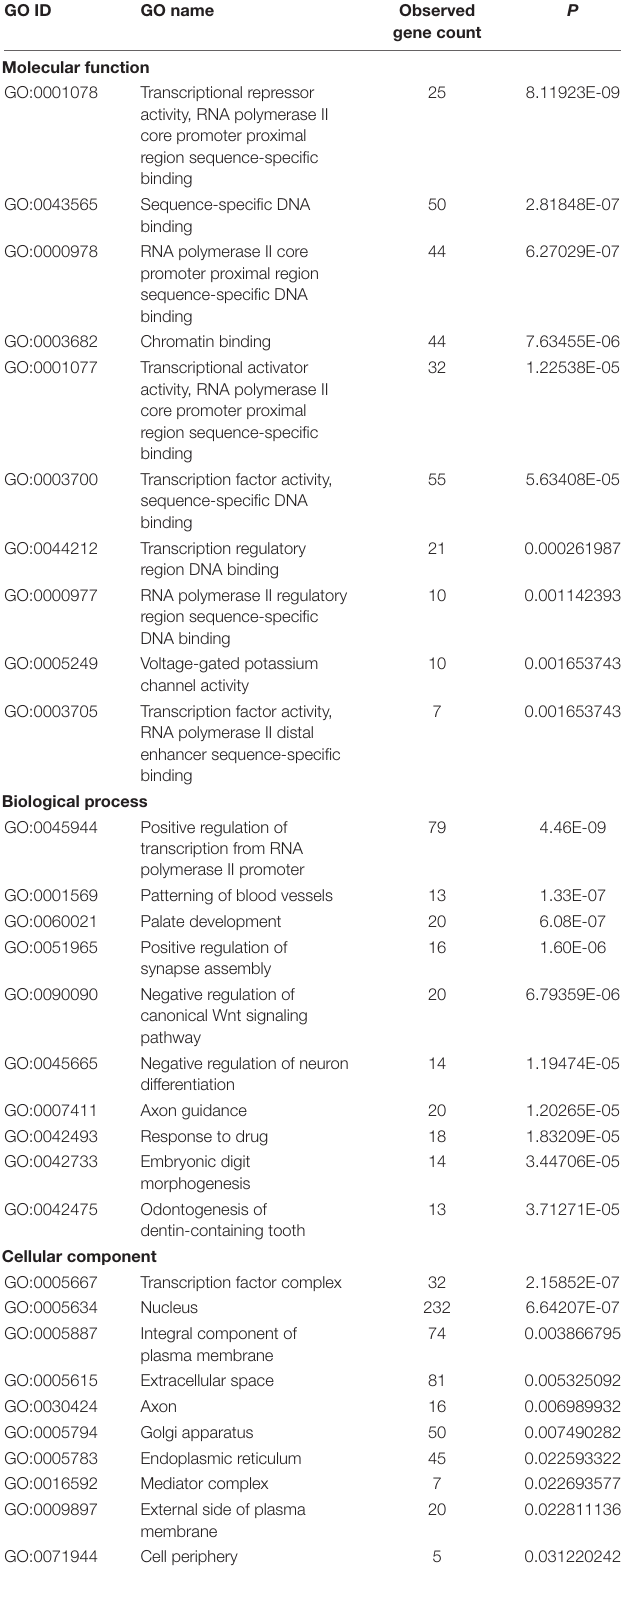
TABLE 3 | Top 10 significantly enriched Gene Ontology (GO) terms of target genes of all long non-coding RNAs